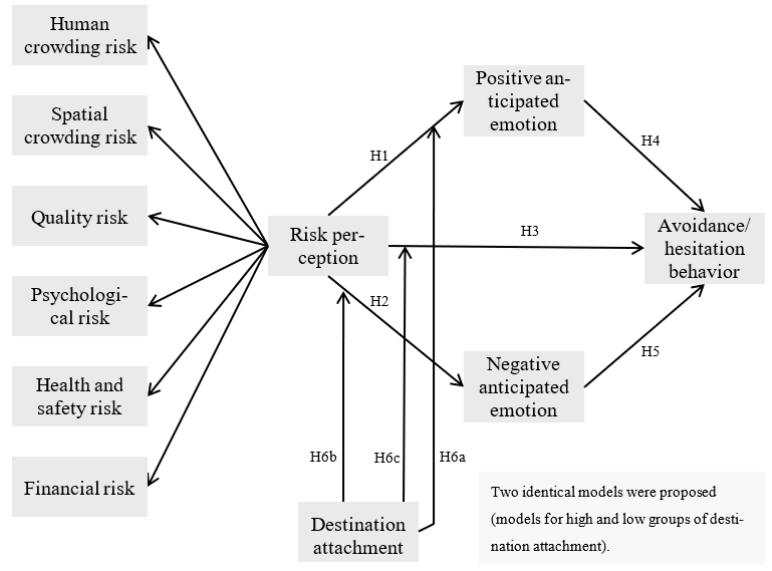
Figure 1. The proposed